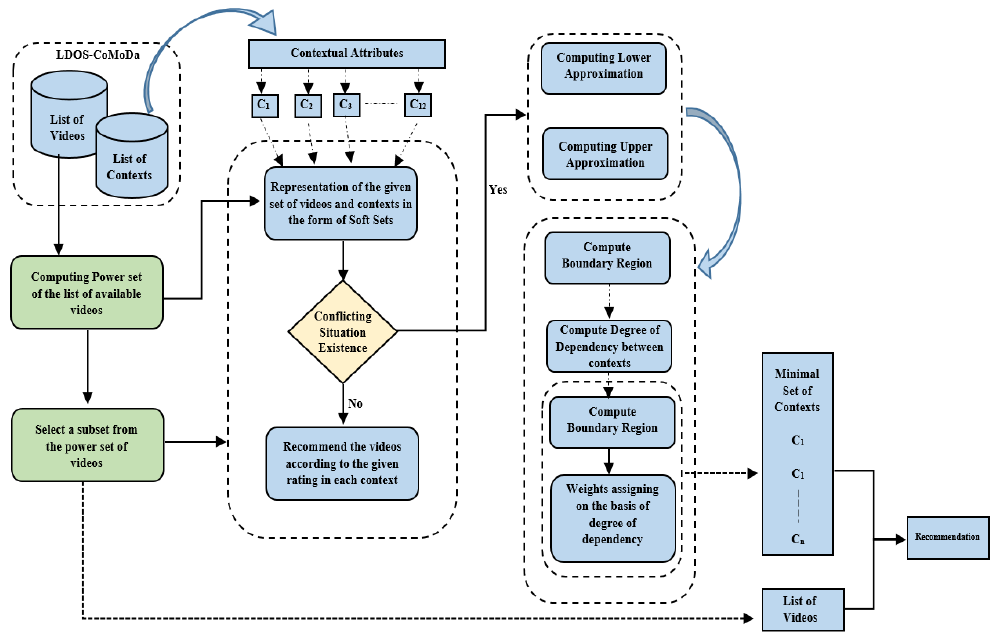
Figure 2. Architecture of the proposed